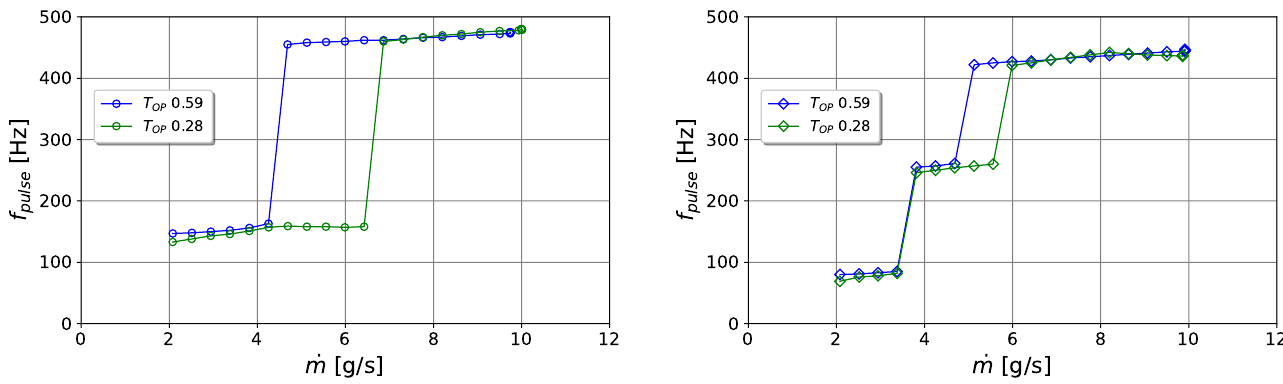
Figure 18. Variation of throttling ratio using the S geometry, a constant, and feedback loop diameter D + = 0.68 and feedback loop length of L + = 7.8 × 10 2 ( left ) respectively L + = 1.5 × 10 3 ( right